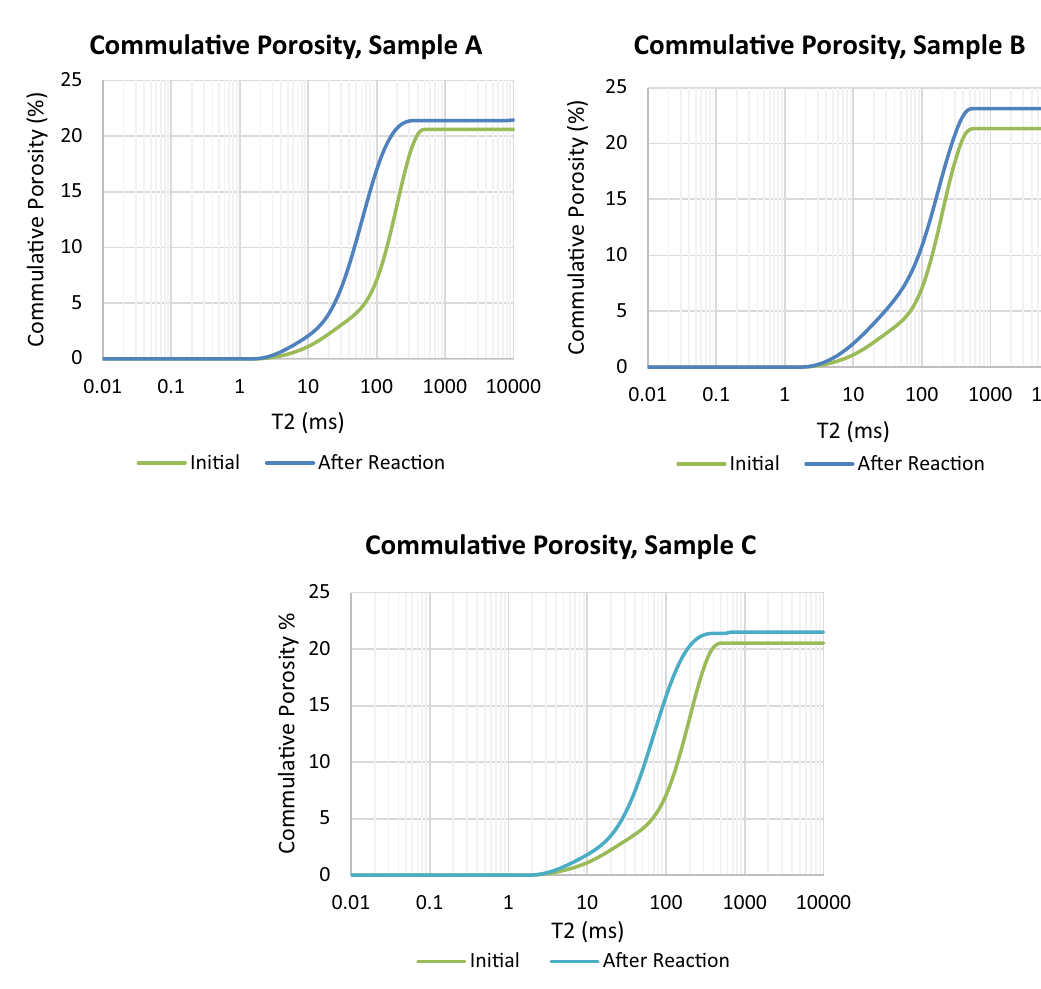
Fig. 15 T2 commulative spectrum of Berea sandstone core samples before and after reaction with